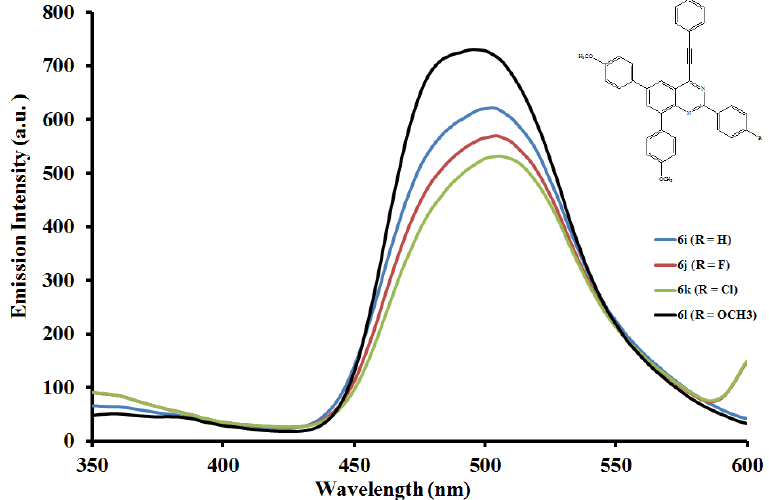
Figure 9. The emission spectra of compounds 6i – l ( λ ex = 400 nm) in DMF (0.022 mmol/L) at